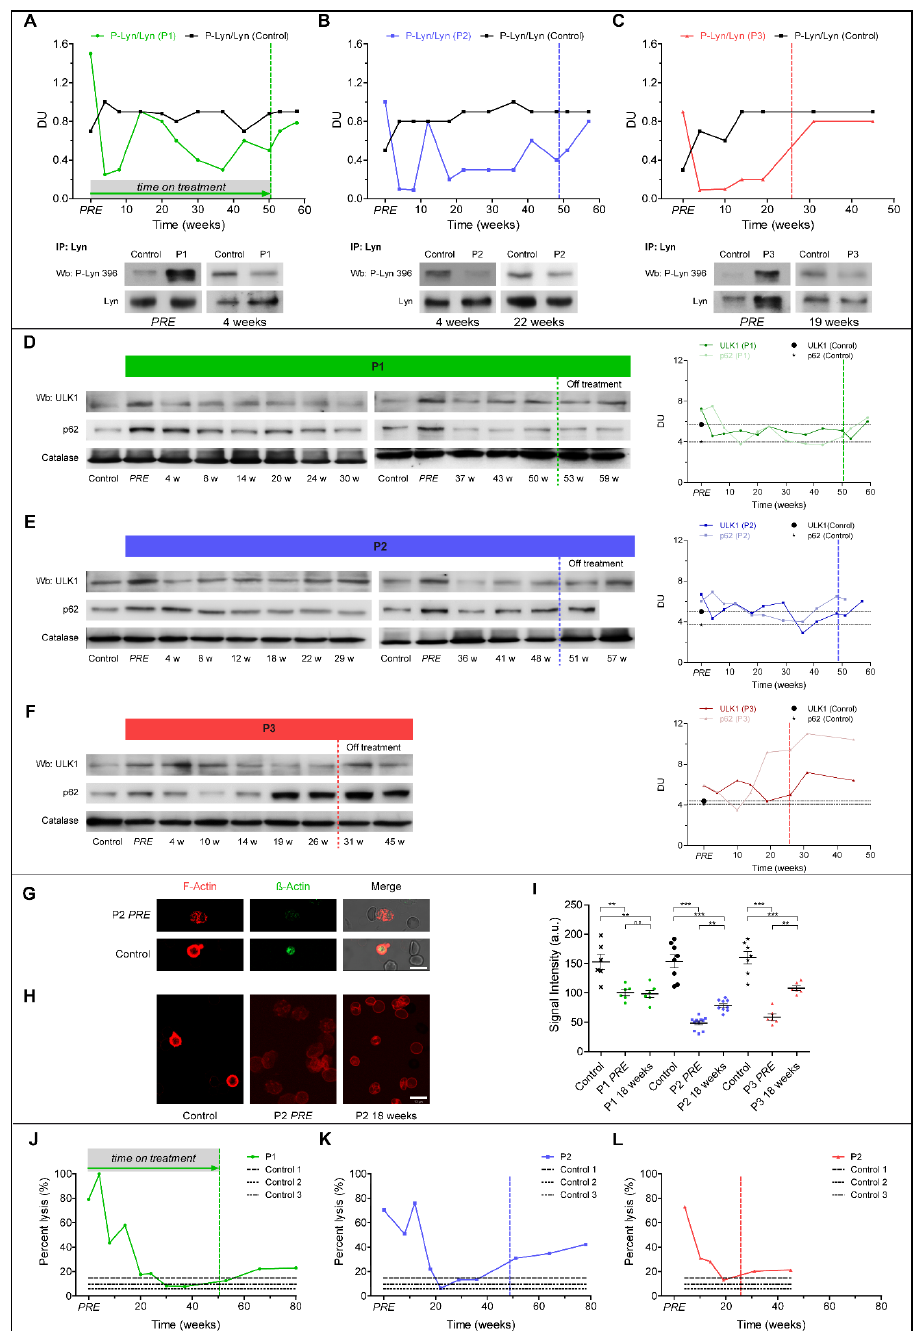
Figure 4. Graphs represent red cell features in ChAc patients. ( A – C ) Total Lyn was immunoprecipitated from blood samples and detected with an antibody against active Lyn (phospho-Lyn 396) or total Lyn (Wb: Western blot). Initially overactive Lyn was suppressed by dasatinib treatment in all three patients. Lyn activity increased after dasatinib withdrawal. ( D – F ) Western blot (Wb) analysis of Ulk1 and p62 in red blood cells (RBCs) and densitometric analyses of the immunoblot bands. ( G ) Confocal microscopy of microfilament actin-fluorescence and transmission light microscopy of RBCs from patient 2 (P2) and the healthy control. Anti- β -Actin-FITC-conjugated antibody-stained total actin and Phalloidin-stained filamentous actin (F-actin). ( H ) Phalloidin was used for F-actin staining. Scale bar: 10 µ m. ( I ) F-actin staining intensity in P1–P3. Shown are the mean values of intensity ± SEM from n = 3 independent experiments. One-way ANOVA/Bonferroni’s multiple comparison test ( p < 0.05). ( J – L ) Osmotic fragility of RBCs is shown as percentage of RBC lysis at a single osmotic point at 158 mOsm in P1–P3. Patients 1–3 (P1–3), PRE: represents baseline value before initiation of dasatinib treatment, dotted vertical lines represent individual end of